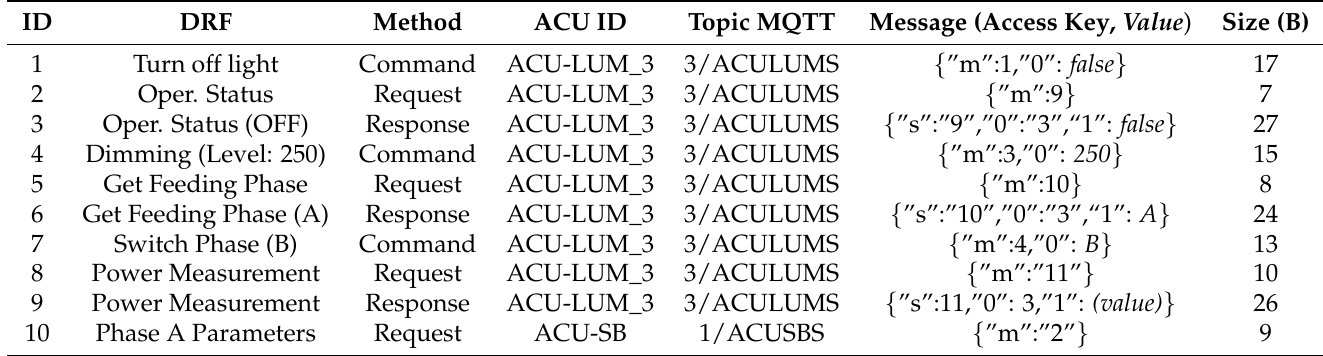
Table 3. Messages used for validation of DRFs of the proposed